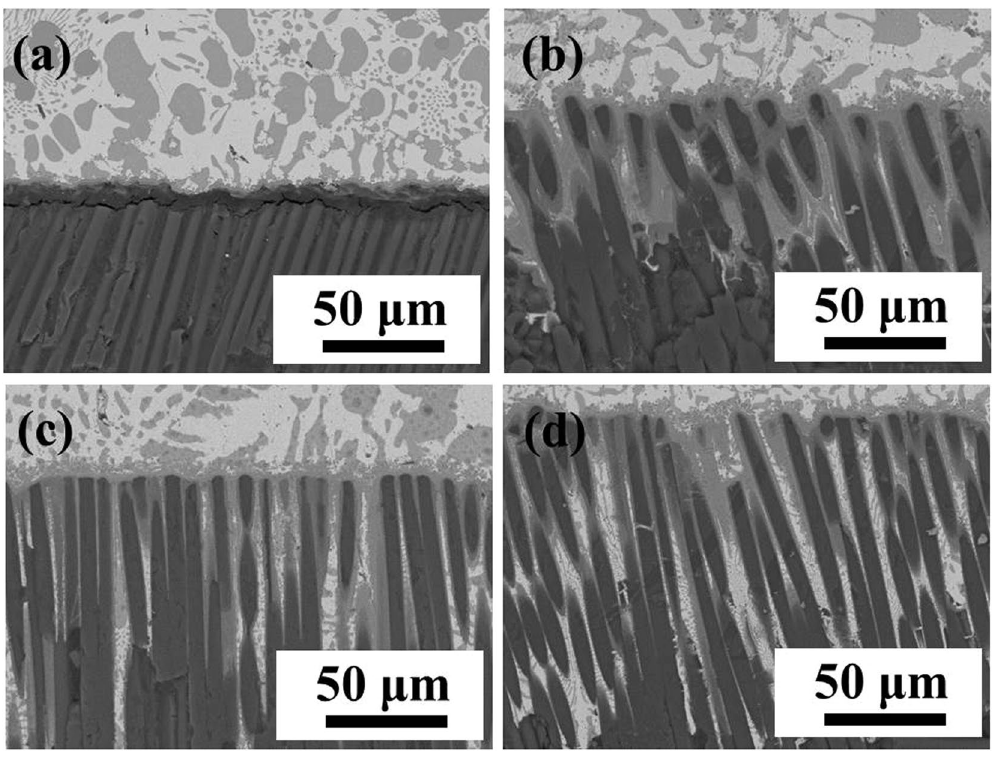
Figure 9. SEM images of wetting region in ( a ) 0 μ m@E-SiO 2f /SiO 2 , ( b ) 50 μ m@E-SiO 2f /SiO 2 , ( c ) 100 μ m@E- SiO